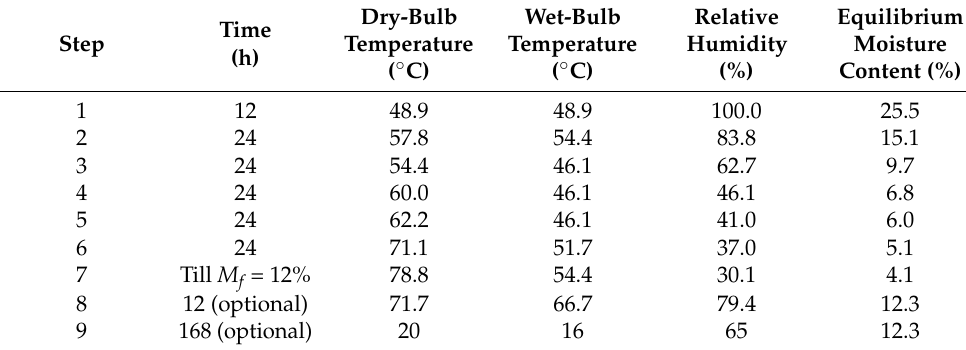
Table 3. First modified schedule. This schedule comprises six time-based steps and one moisture- based step, followed by optional conditioning (step 8) and optional post-storage (step